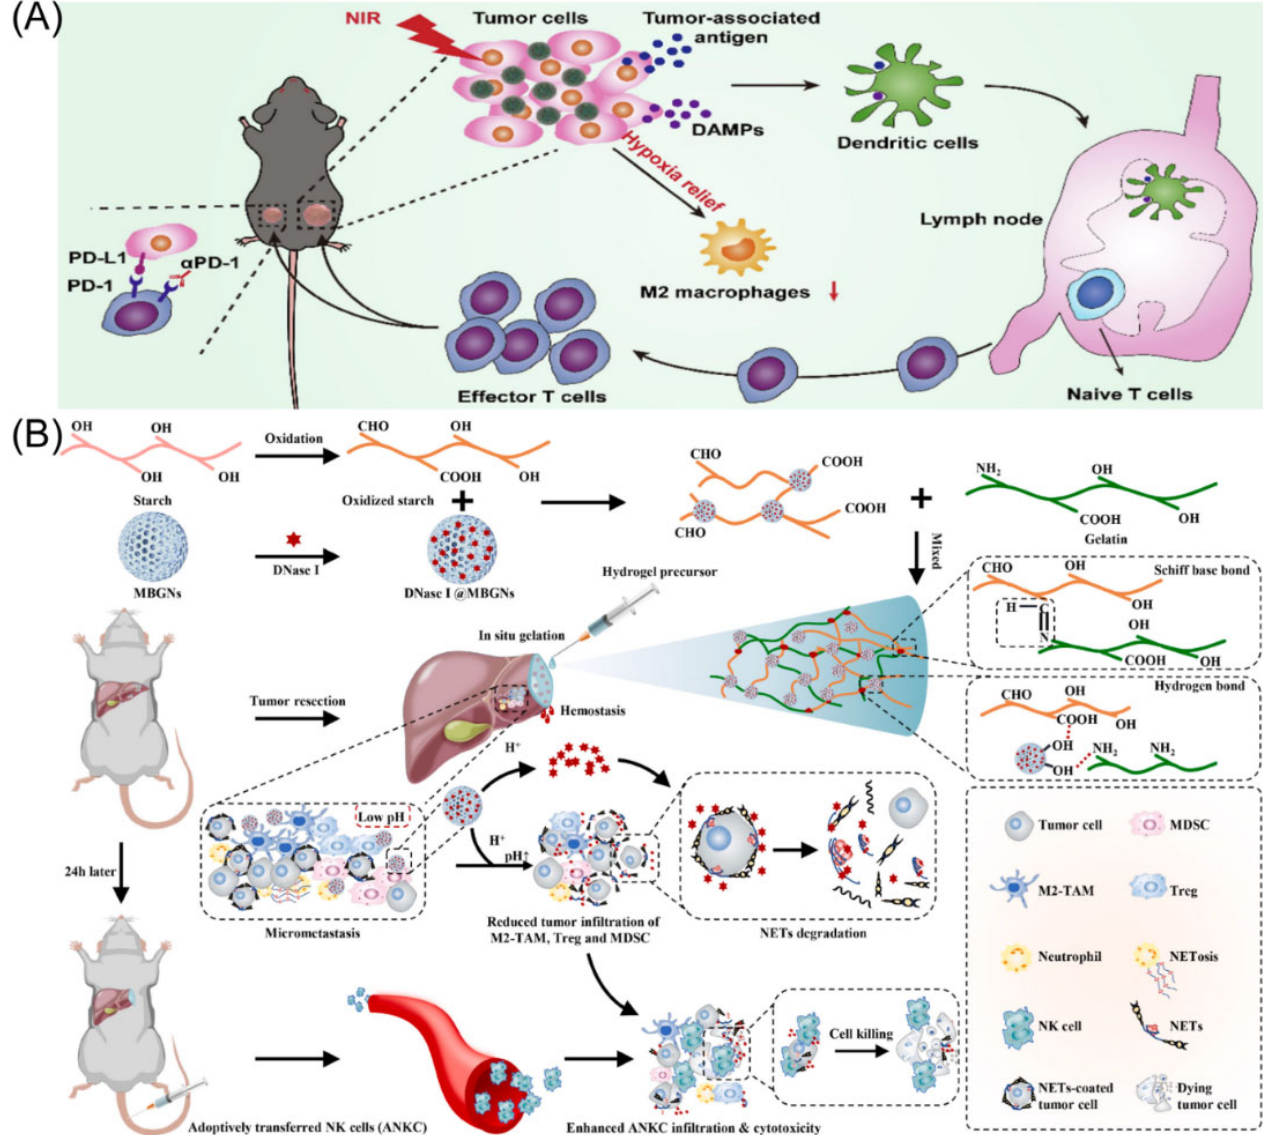
Figure 2. ( A ) The strategy through which BHMDI ‐ induced ICD potentiates PD ‐ 1 blockade. Copy ‐ right 2022, Elsevier [45]. ( B ) Diagram of adhesive hemostatic gel preparation and combined treat ‐ ment. Copyright 2022, Elsevier